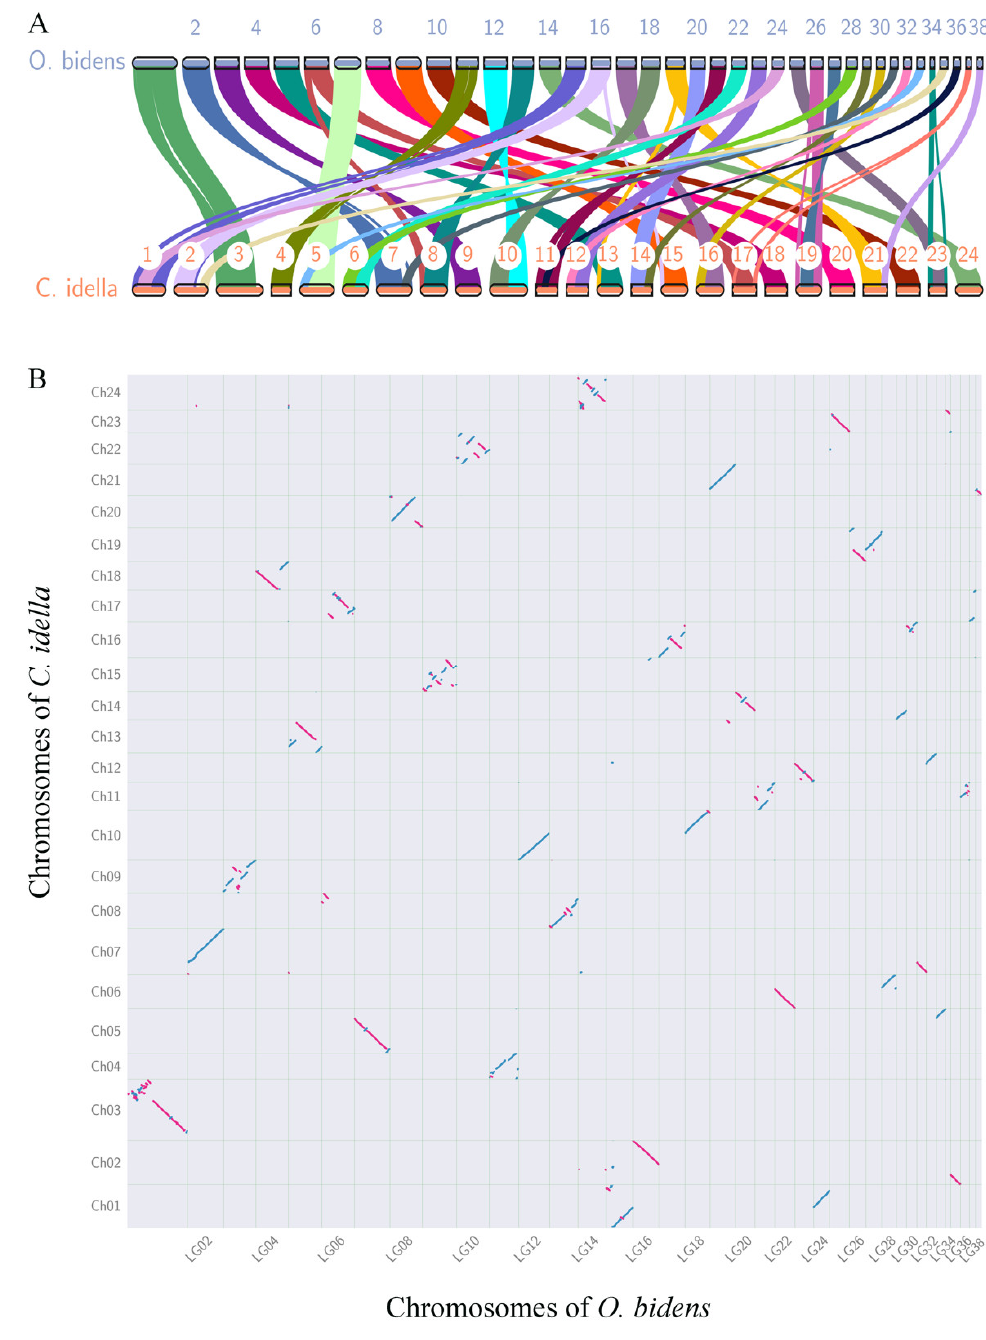
Figure 8. Chromosome conserved synteny analysis between male O. bidens and grass carp genome. ( A ) The chromosomes in the two genomes showed multiple chromosomes breaking off in grass carps corresponding to chromosomes in male O. bidens . ( B ) Detail inter-genomic conserved blocks with 21,628 gene pairs between grass carp and male O. bidens genome.